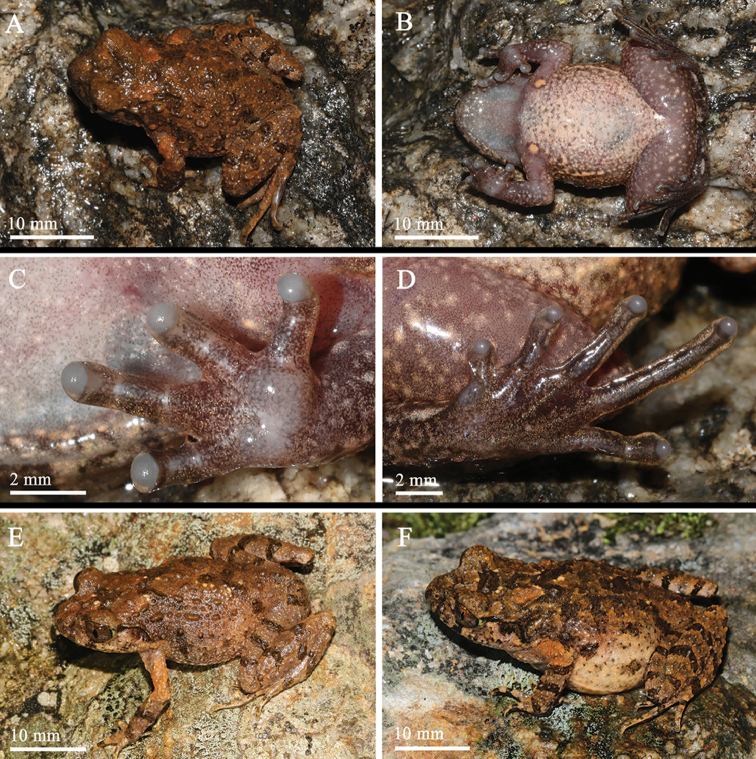
General aspect in life: A–DSYS a004665, the male holotype of Leptobrachellayunkaiensis sp. n. ESYS a004667, the male paratype FSYS a004690, the female paratype.